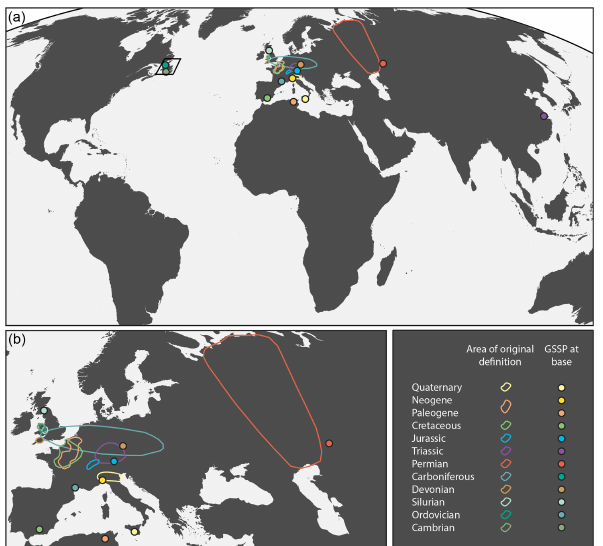
Figure 2. (a) Global location of 19th century definition areas of systems in the geological timescale compared with boundary stra- totypes defined and proposed by the International Commission on Stratigraphy (ICS) (Gradstein et al., 2012). Box encloses the area of Fig. 1a. Molleweide projection; ICS colour scheme for strati- graphic units. (b) Enlarged portion of (a) showing the concentra- tion of definition areas and stratotypes in Europe. Coastline made with Natural Earth Data: free vector and raster map data at http: //naturalearthdata.com/ (last access: 17 February 2020).